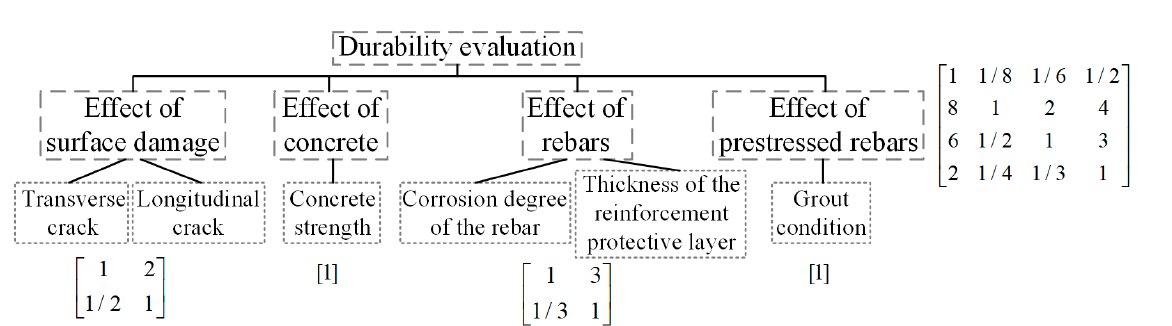
Figure 14. Pairwise comparison matrix.